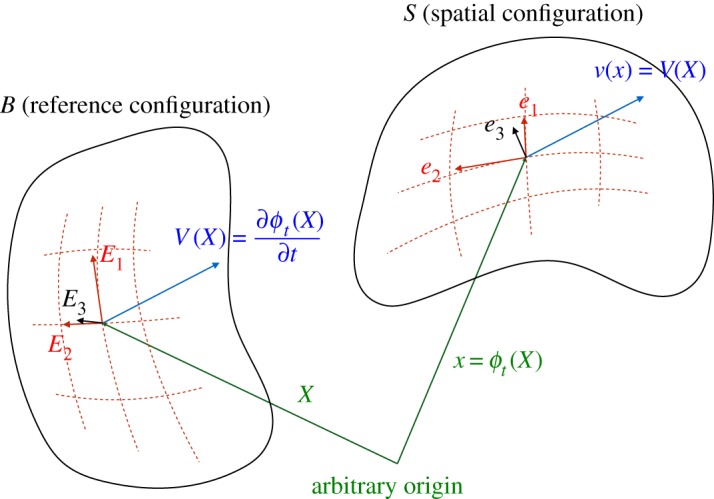
Surface geometry.